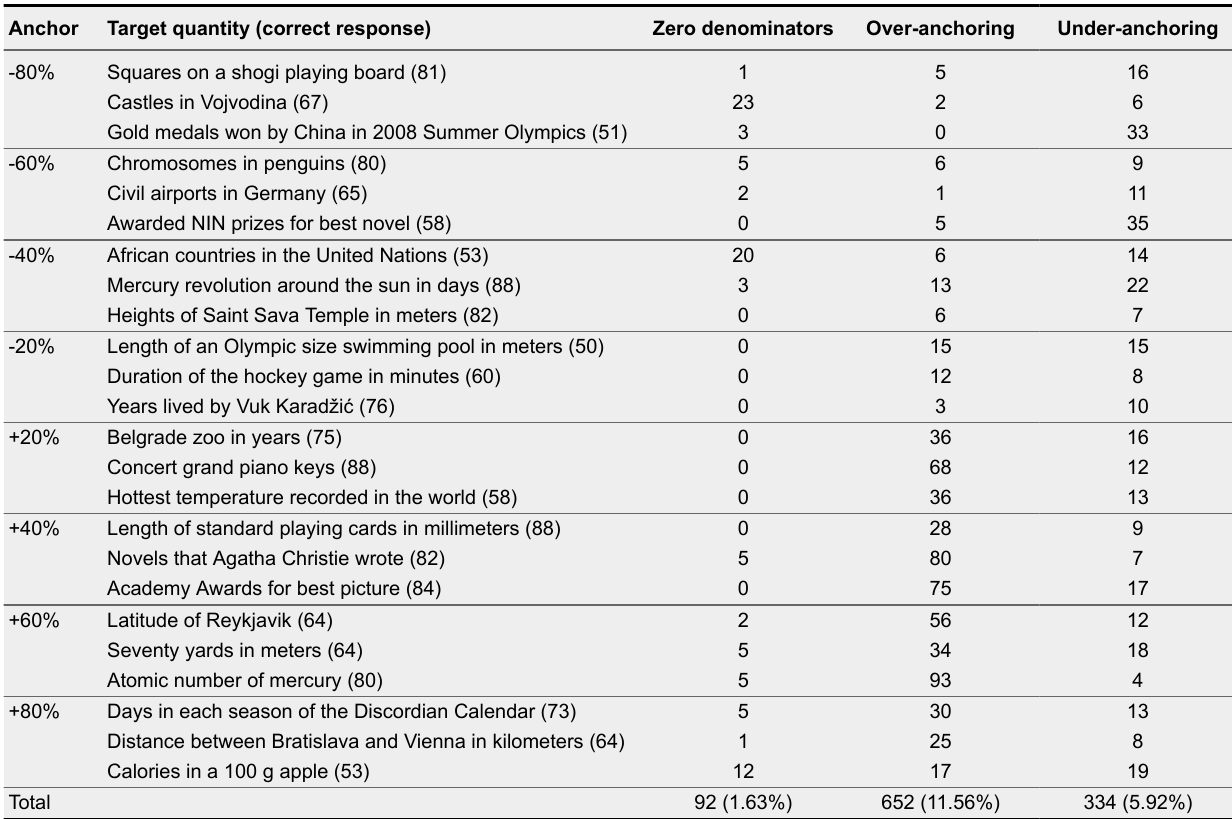
Distribution of Missing and Trimmed Data in the Anchoring Experiment